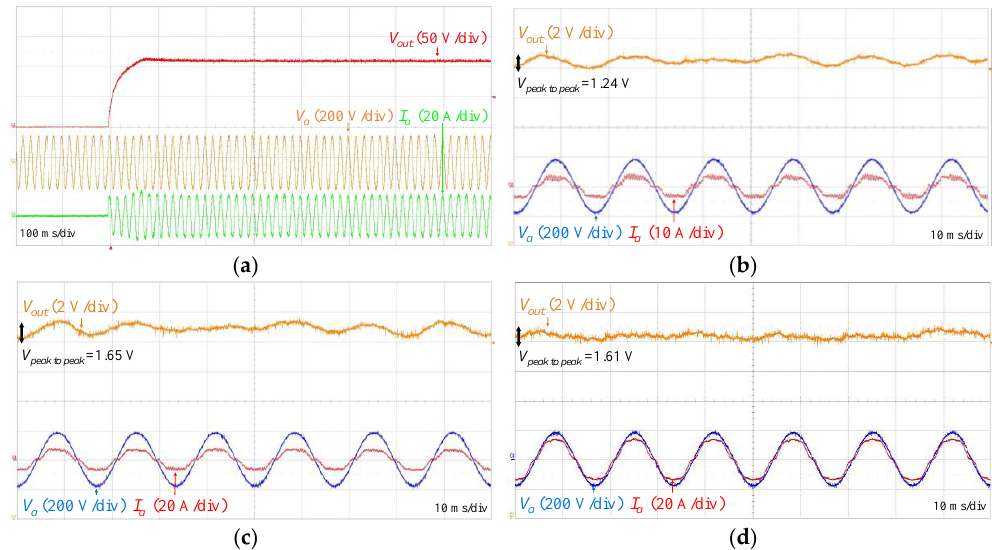
Figure 13. Experimental waveforms of the proposed buck rectifier: ( a ) Transient operation, ( b ) P out = 800 W, ( c ) P out = 1700 W, ( d ) P out = 3600 W.